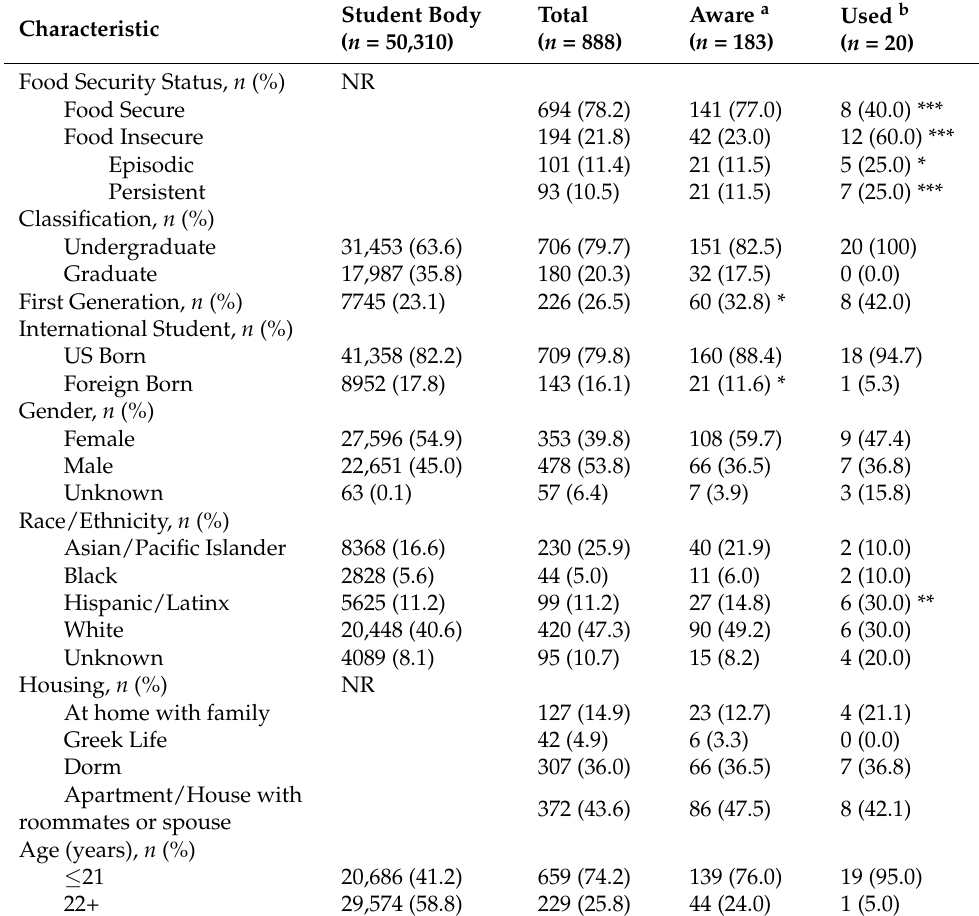
Table 1. Sociodemographic characteristics of students who participated in an online campus survey and were aware of and used the campus food pantry compared with the campus student body ( n =